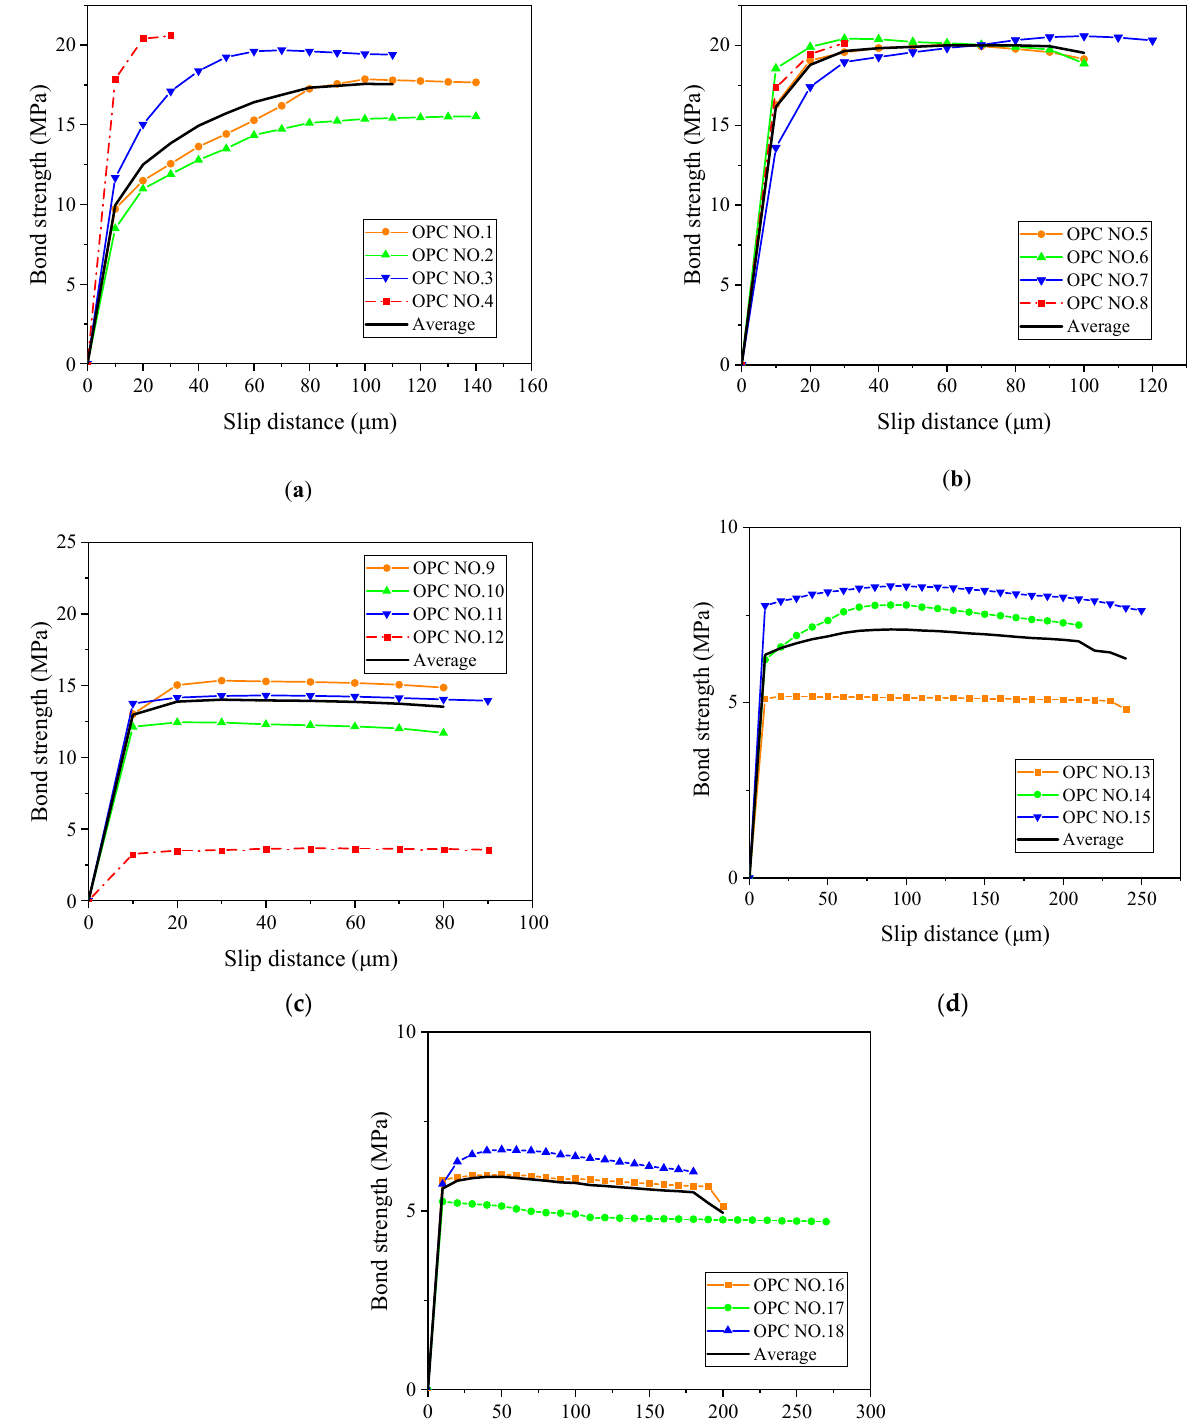
Figure 11. OPC bond–slip curve (actual corrosion degree): ( a ) control; ( b ) 0.22%; ( c ) 0.97%; ( d ) 2.24%; and ( e ) 3.43% .